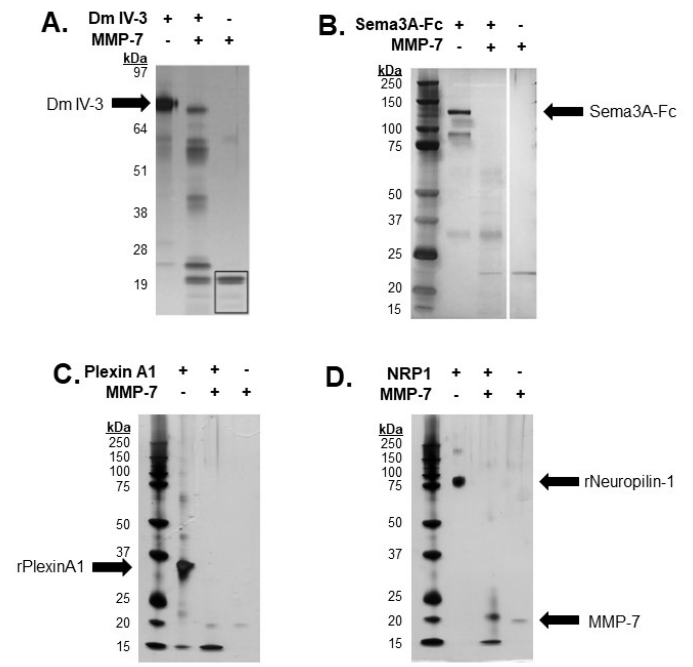
Figure 3. In vitro digestions of all PSPN Complex components demonstrate susceptibility to proteolysis by MMP-7. Silver stain of Dm IV-3 incubated with or without MMP-7 (adapted [5]) (A) , MMP-7 digestion of Sema3A-Fc (0.75 µg) with or without MMP-7 (0.08 µg) overnight (adapted [4]) (B ). Digestion of recombinant plexin A1 (2 µg) (C) and NRP1 (2 µg) (D ) overnight with or without MMP-7 (0.2µg). Black arrows indicate recombinant Dm IV-3, Sema3A-Fc, plexin A1, NRP1 and